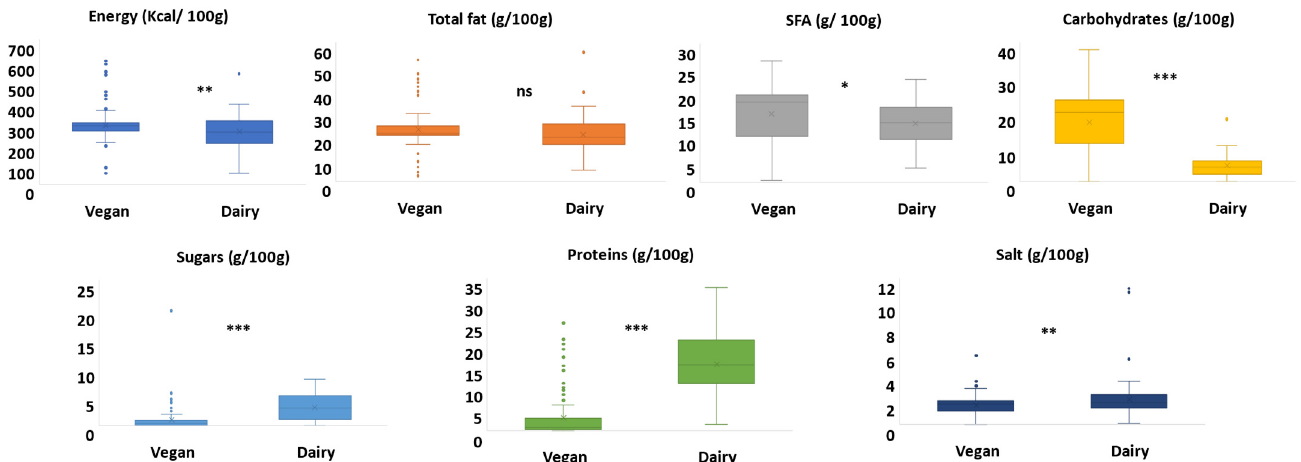
Figure 2. Nutritional profile of vegan alternatives to processed cheese ( n = 114) vs. dairy processed cheese ( n = 115). The box-plot legend: the box is limited by the lower (Q1 = 25th) and upper (Q3 = 75th) quartile; the median is the horizontal line dividing the box; whiskers above and below the box indicate the 10th and 90th percentiles; outliers are the points outside the quartile 10–90th percentiles. *: p < 0.05, **: p < 0.01, ***: p < 0.001, ns: non-significant ( p > 0.05).